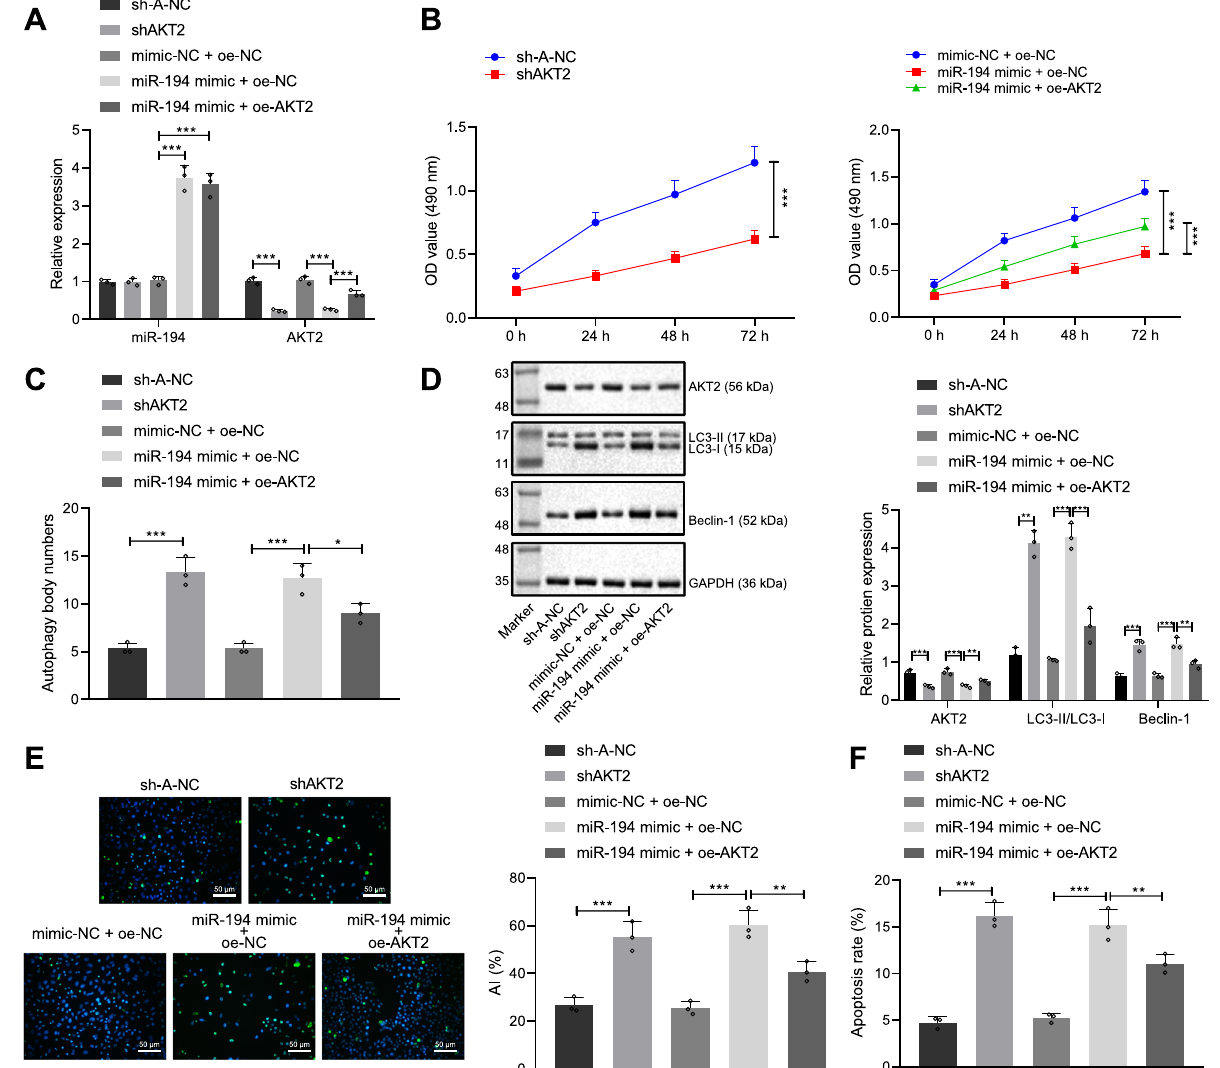
Fig. 3 Overexpression of miR-194 promotes GC cell autophagy by targeting AKT2. A qRT-PCR to measure the expression of miR-194 and AKT2 in transfected cells; B MTT assay to assess the viability of transfected cells (Asterisk (*) signs indicate the p values for the entire difference between the curves); C quantitative analysis of autophagy of transfected cells under observation of transmission electron microscope; D western blot assay to measure the expression of AKT2 and autophagy-related proteins (LC3-I, LC3-II, and Beclin-1) in transfected cells; E TUNEL assay to detect TUNEL-positive apoptotic cells (200×); F fl ow cytometric analysis for the apoptosis rate of transfected cells; * p < 0.05, ** p < 0.00, *** p < 0.0001. The measurement data are summarized by mean ± standard deviation. Data in A – F were analyzed by one-way ANOVA